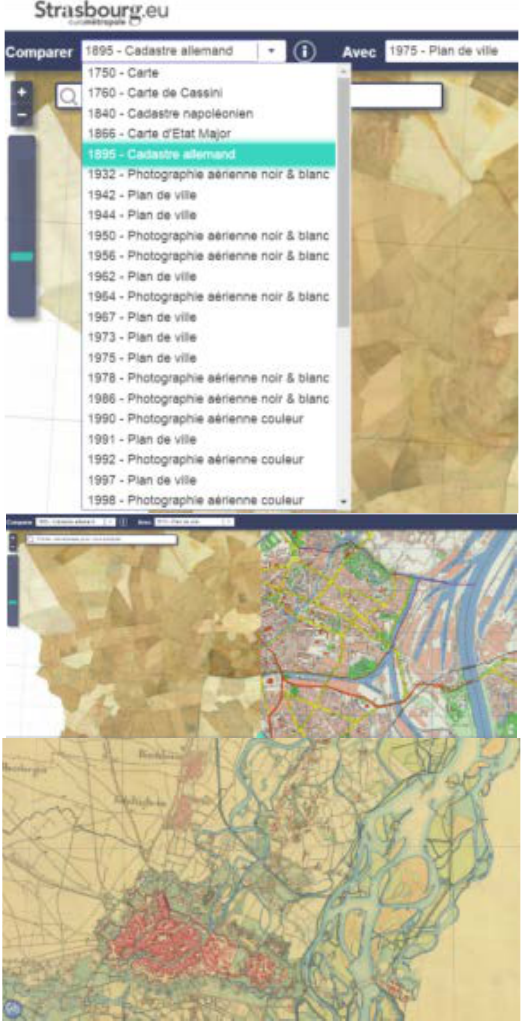
Figure 1. “Strasbourg au fil du temps”: the website implemented by the City of Strasbourg with the list historical georeferenced maps (upper). The cadastre allemande (1895) coupled to the current map of the city (centre). Below a detail of the French map (Carte de l’Etat-Major 1820-1866), the Strasbourg area before the design of the German administration